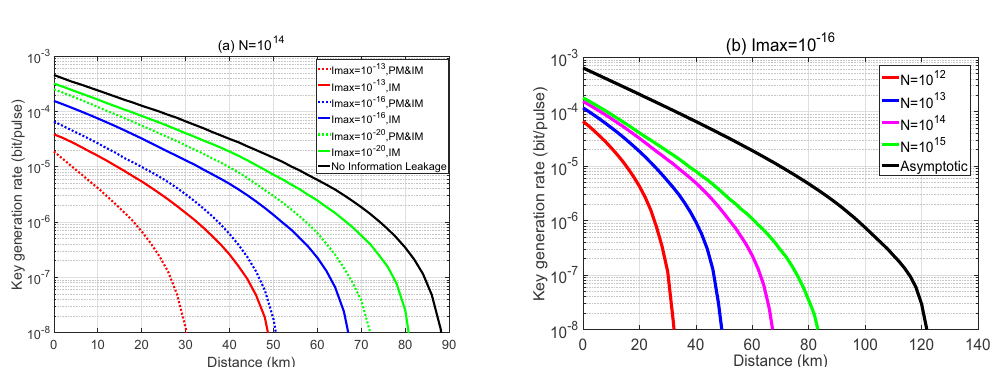
Figure 3. The secret key rate in logarithmic scale as a function of the distance in Case 1 for the three-intensity protocol. ( a ) Here we consider a fixed value of the total number of transmitted pulses, N values for the intensity I max . ( b ) Here we fix I max evaluate information leakage from the IM